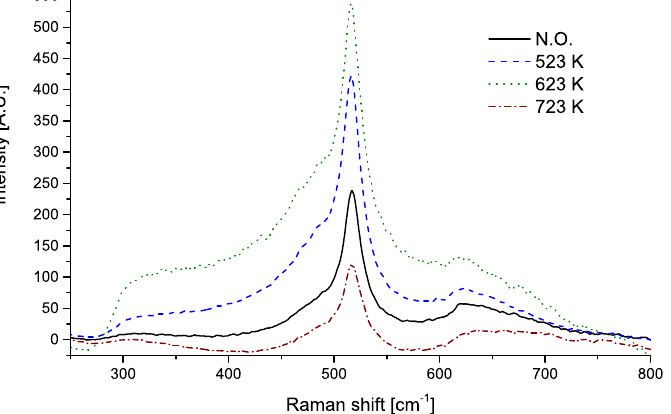
Figure 5. Raman spectra of samples oxidized at different temperatures. Legend shows oxidation temperature in Kelvin, while N.O. stands for samples that were not thermally oxidized.